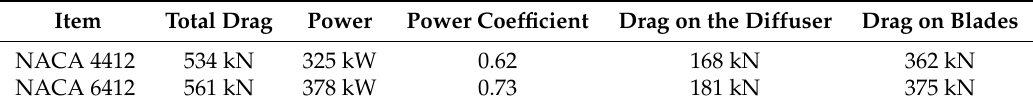
Table 2. Efficiency analysis of diffusers with an airfoil